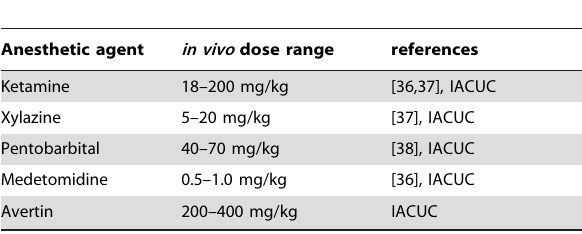
Table 2. Physiological anesthetic ranges for injectable